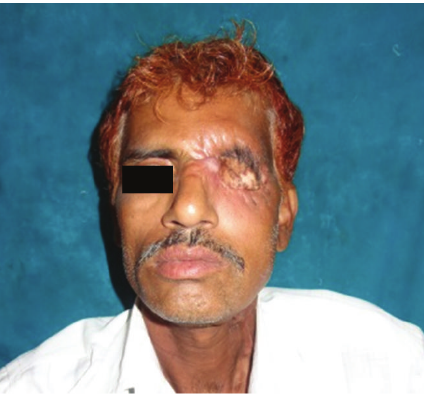
Figure 6: Temporalis muscle flap transpositioned.